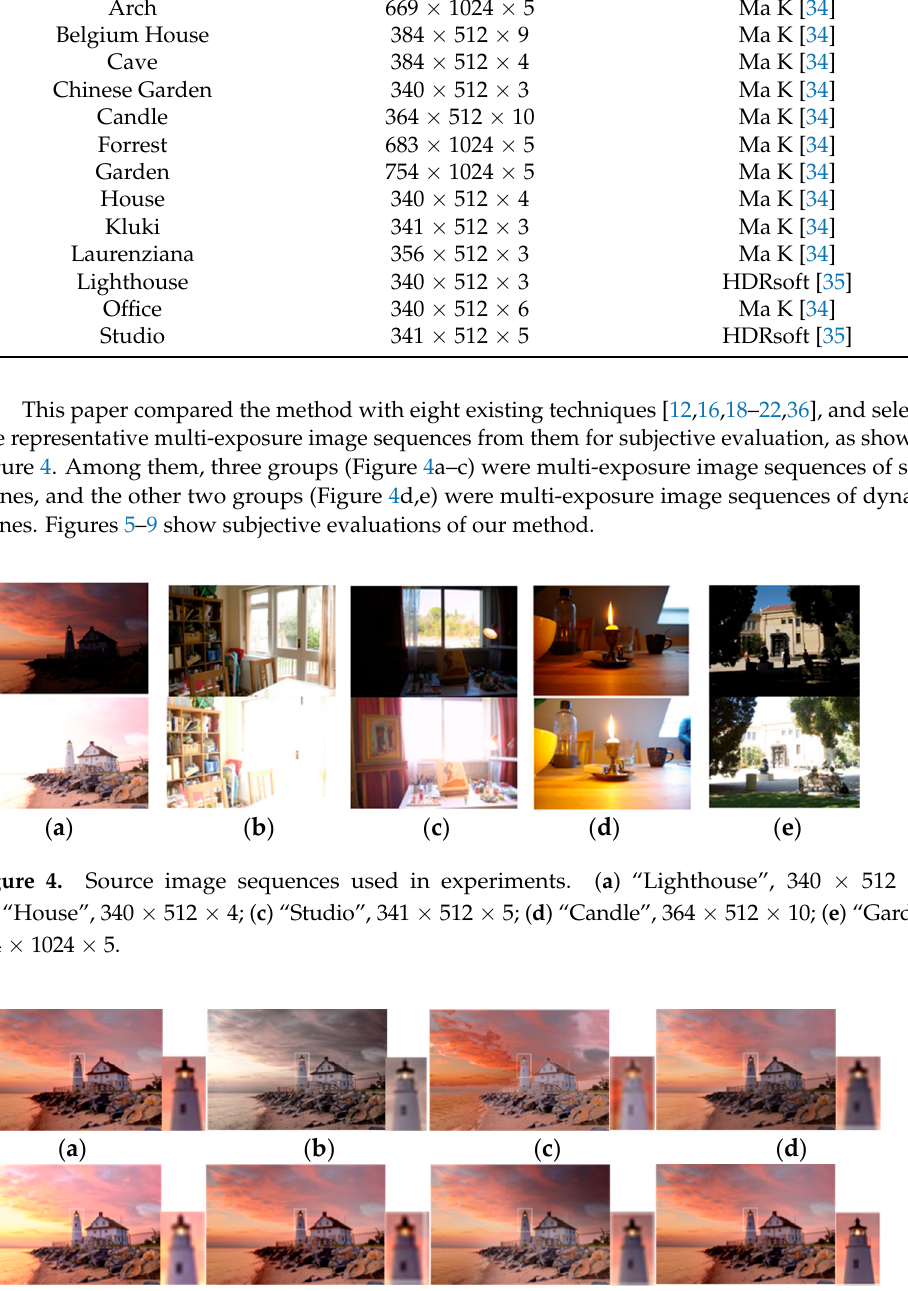
Figure 5. Results of different methods on the image sequence “Lighthouse”. ( a ) Mertens et al. [12]. ( b ) Gu et al. [16]. ( c ) Shen et al. [18]. ( d ) Bruce et al. [19]. ( e ) Photomatix [36]. ( f ) Hayat et al. [21]. ( g ) Huang et al. [22]. ( h ) Proposed